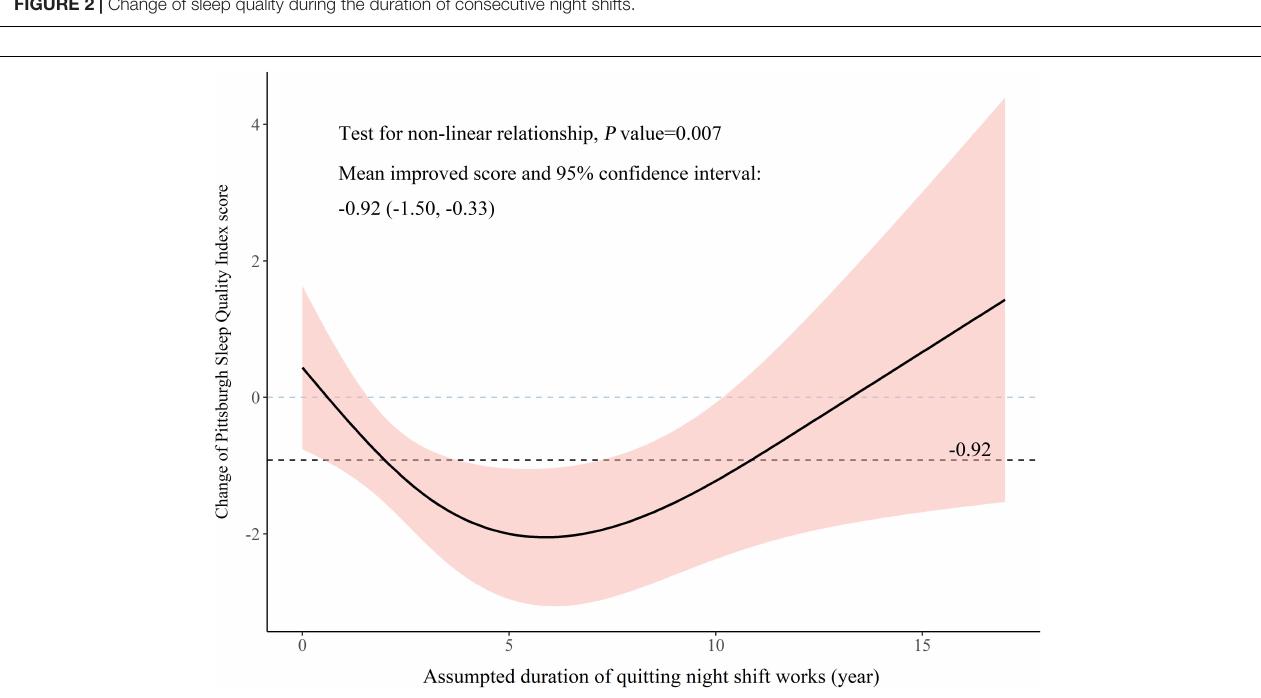
FIGURE 3 | Change of sleep quality after quitting night shifts based on the hypothetical prospective cohort constructed from cross-sectional data.